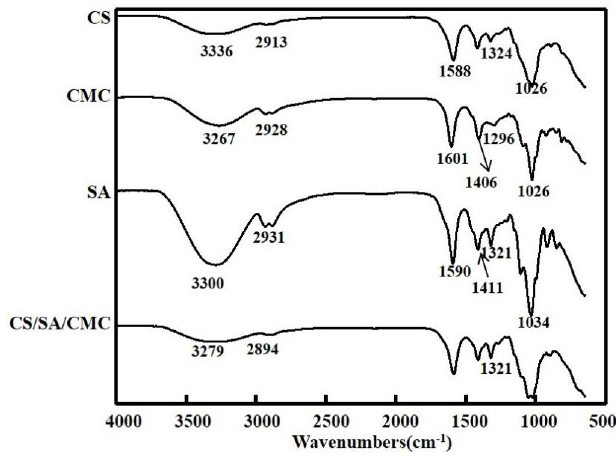
Figure 2. FTIR spectrum of CS, CMC, SA, and CMC/SA/CS fibers.